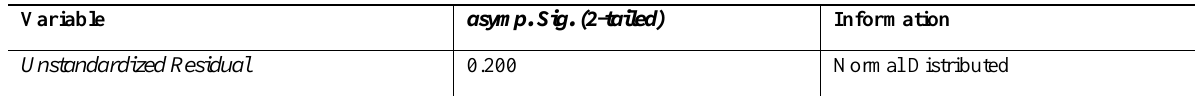
Table 4: Normality Test